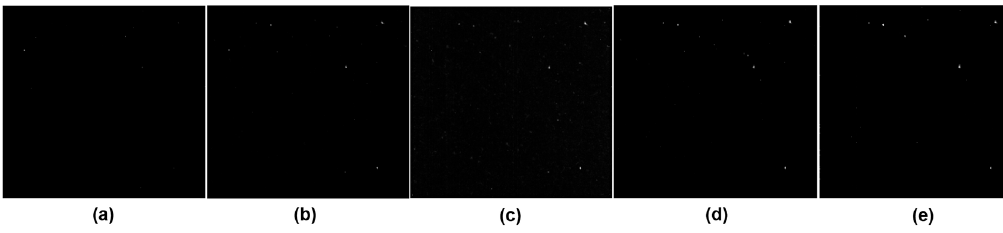
Figure 11. The normalized detection maps of Botswana dataset before threshold segmentation: ( a ) GRX; ( b ) LRX; ( c ) CRD; ( d ) LRaSMD; and ( e ) RSLAD.